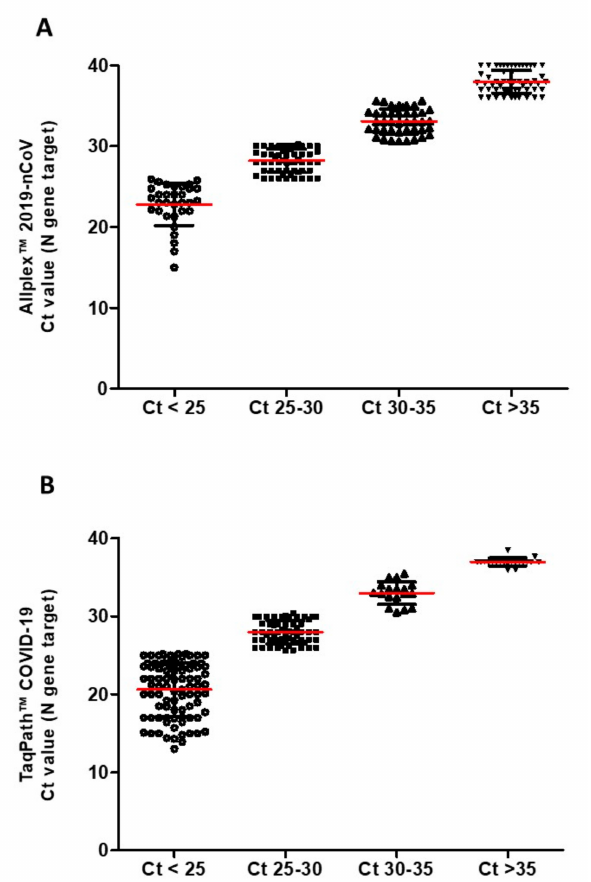
Figure 2. ( A ) Allplex™ 2019-nCoV Assay and ( B ) TaqPath™ COVID-19. In red, the average value is indicated for each